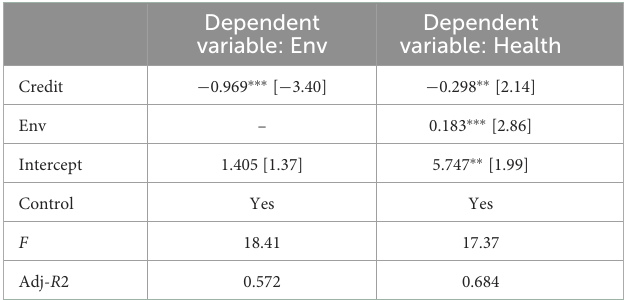
TABLE 4 Bootstrap test results. TABLE 5 Regression results of the mediating